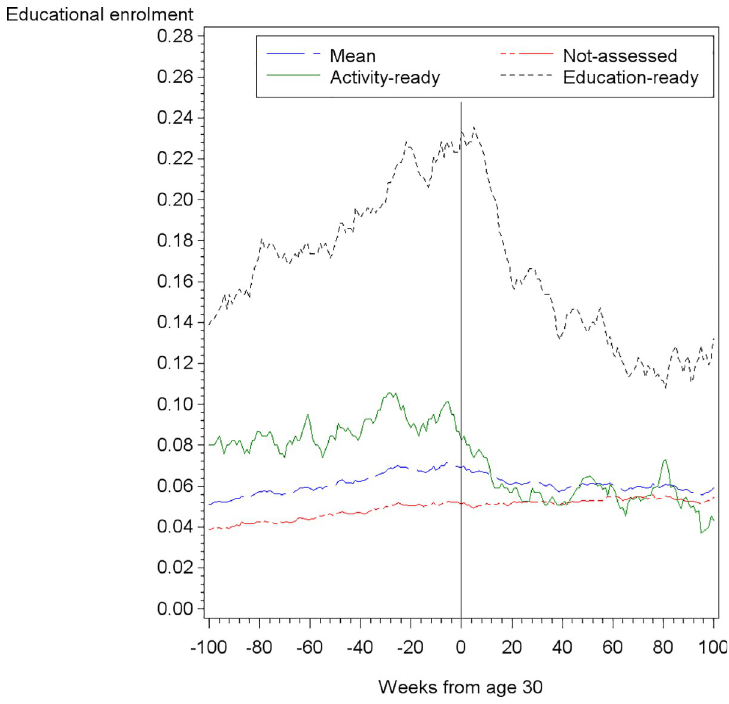
Fig 3. Mean education enrolment for young adults with low qualifications, by assessment category.